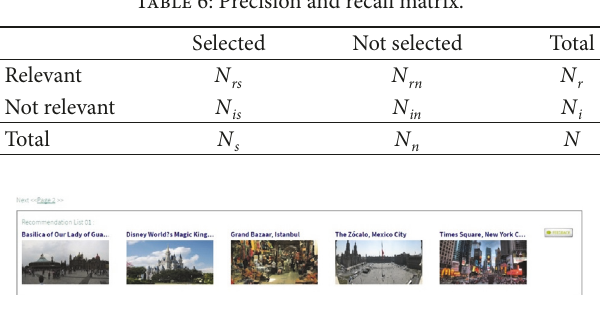
Figure 9: Recommendation